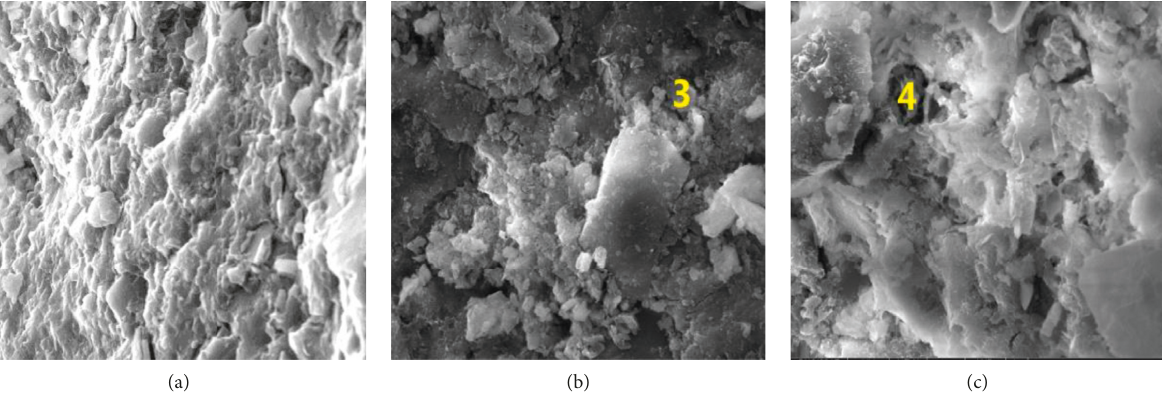
Figure 6: SEM images of C50 concrete: (a) B1, (b) B3, and (c) B5.